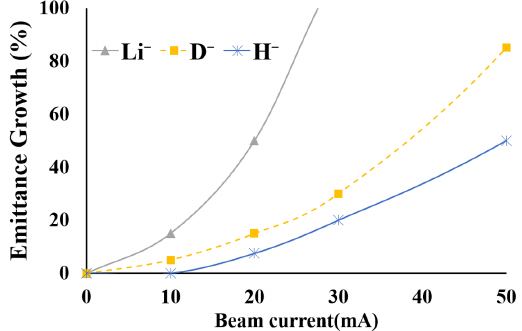
FIG. 5. Emittance growth vs beam current in a 0.5 m drift section using the secondary particles ( SCC - SPI ) to compensate the 50 keV negative beams.